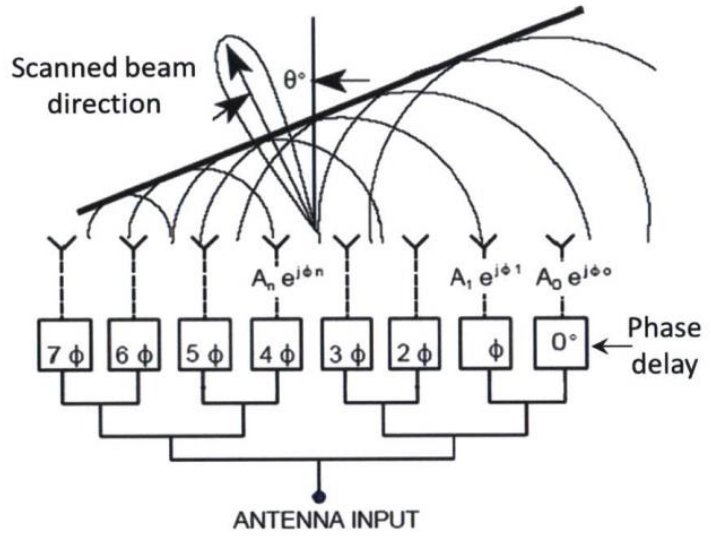
Figure 11. Illustration of beam steering using eight element optical phase array connected in tree architecture. [73].